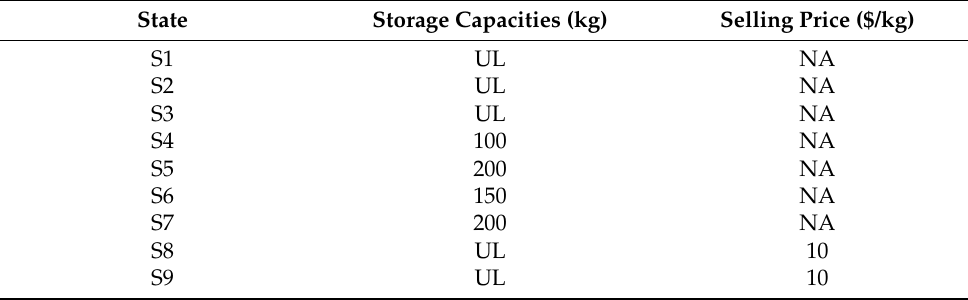
Table A2. Storage limits and the selling price of various states for case study 1